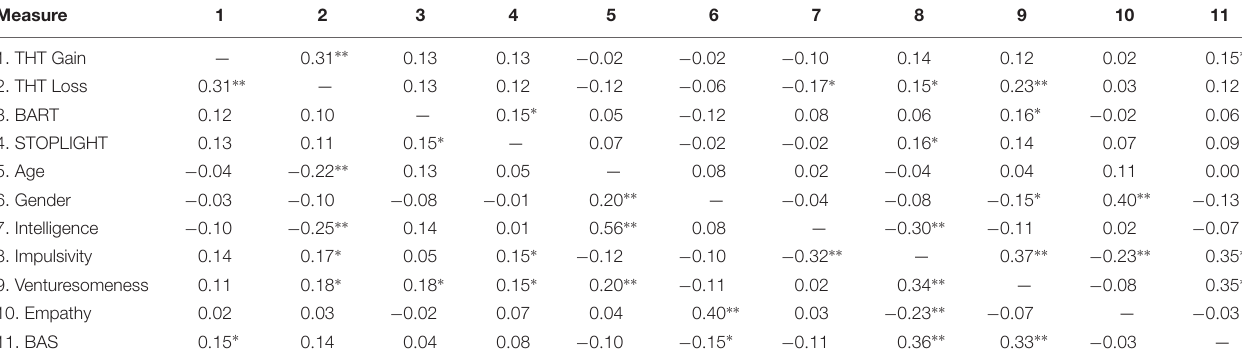
TABLE 3 | Intercorrelations among the study